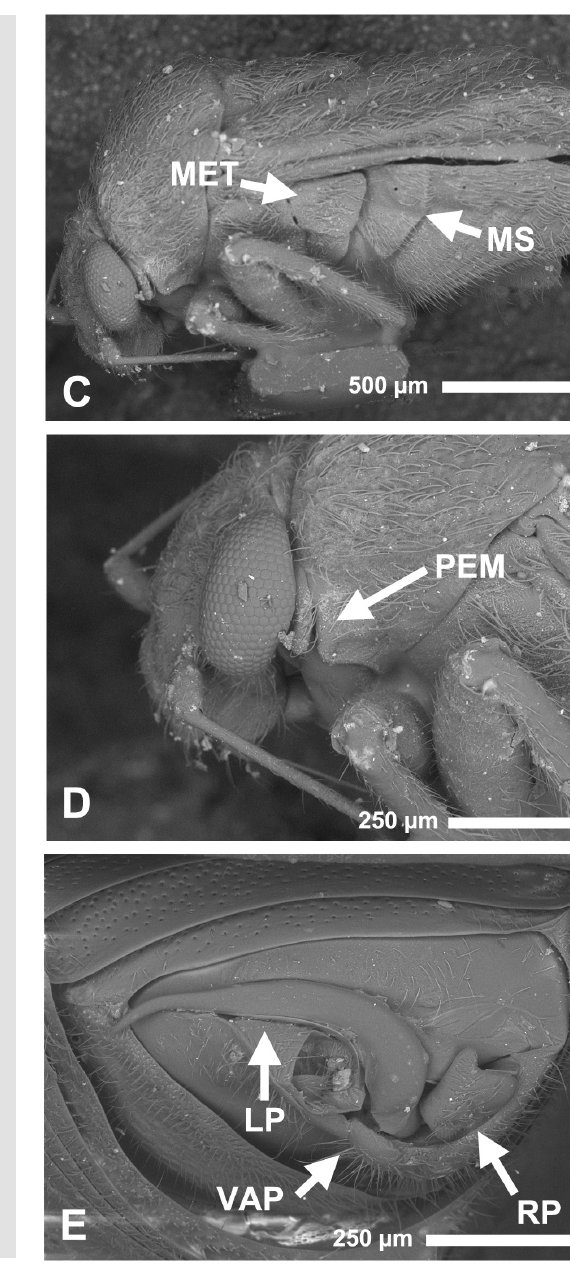
Fig. 1. Photographs and scanning electron micrographs of Coridromius basilanus sp. nov. A . Head and pronotum, anterior view. B . Dorsal habitus. C . Lateral view. D . Head and prothorax, lateral view. E . ♂ genitalia. LP = left paramere, MET = metepimeron, MS = mesal sulcus, PEM = proepimeron, rP = right paramere, VaP = ventral apical process of